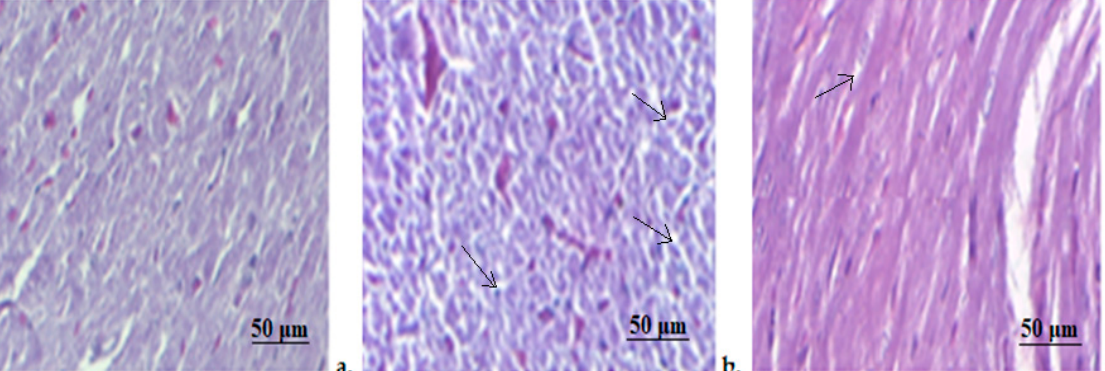
Figure 6. Myocardial histopathological exam. ( a ) Control group; ( b ) STZ group; ( c ) STZ+Zn group. (arrow—polymorphonuclear infiltration). Masson trichrome stain x 20.